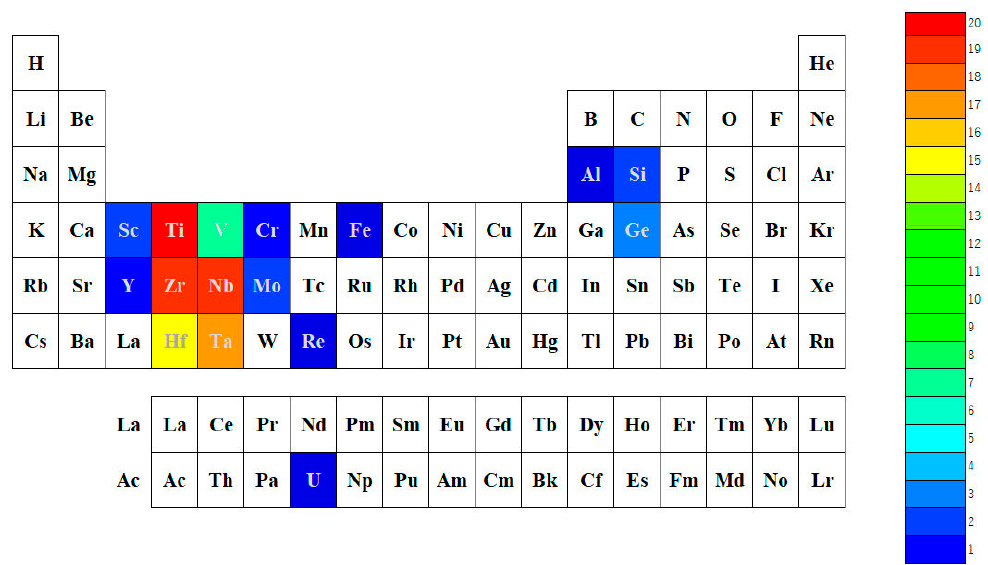
Figure 4. Frequency with which elements are used in bcc HEA superconductors reported to date (Nos. 1–20 in Table 1). The frequencies are 1 for Al, 2 for Si, 2 for Sc, 20 for Ti, 7 for V, 1 for Cr, 1 for Fe, 3 for Ge, 1 for Y, 19 for Zr, 19 for Nb, 2 for Mo, 15 for Hf, 17 for Ta, 1 for Re, and 1 for U.